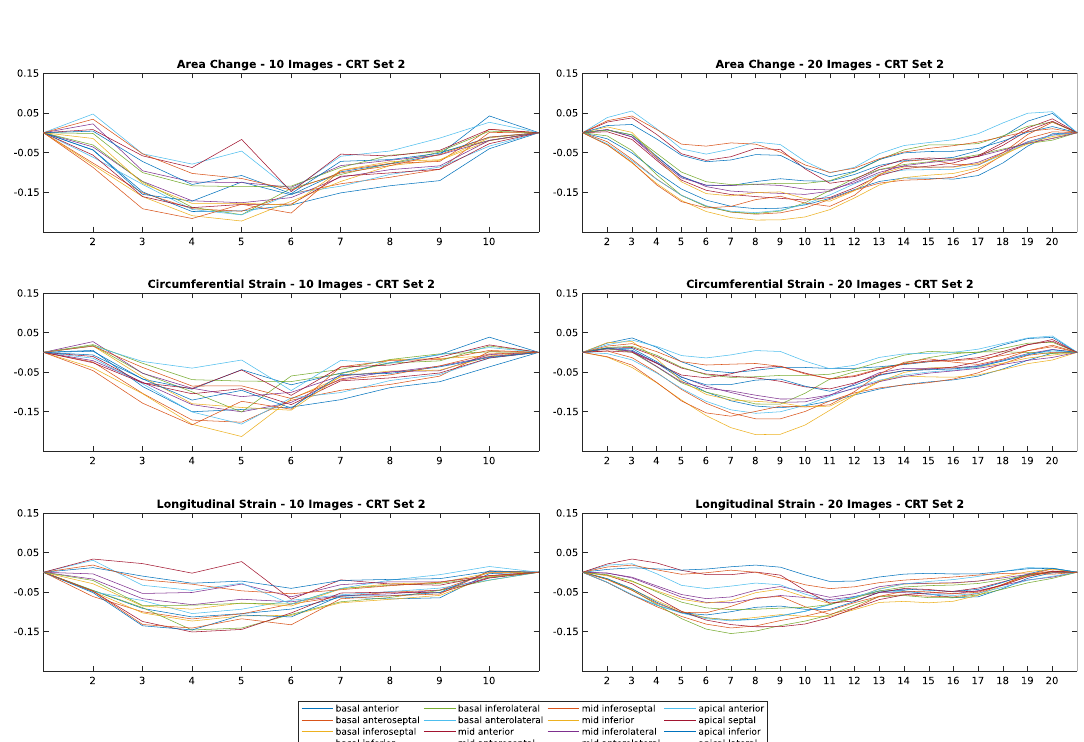
Figure 8. Effect of 20 frames over the cardiac cycle instead of 10 on the three strain (area, circumferential, longitudinal) curves. The plot is from one representative dataset. X axis displays the temporal frame in the cardiac cycle and Y axis is the calculated